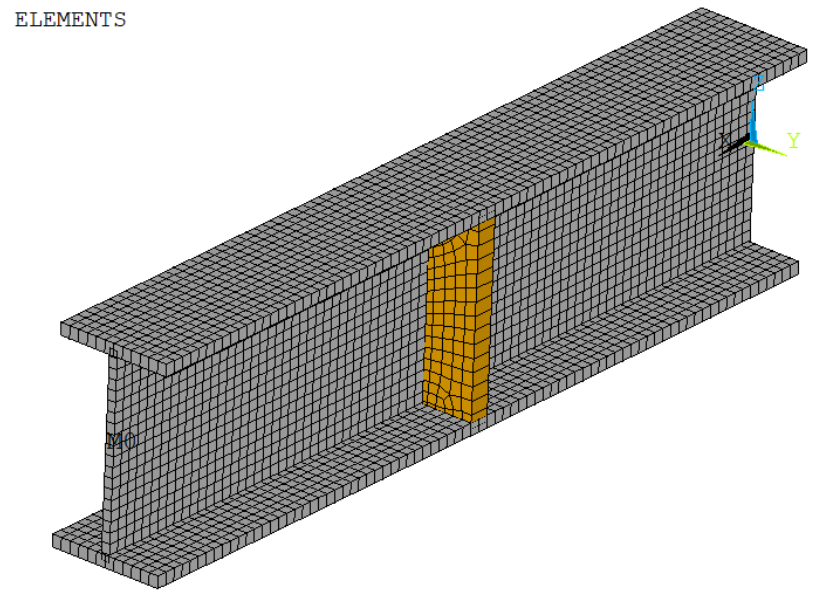
Figure 13. Detail of the web stiffener.